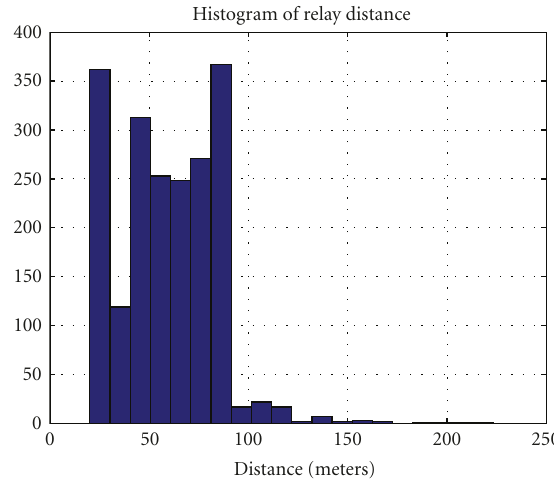
Figure 8: Distribution of the distance between RS and MS.